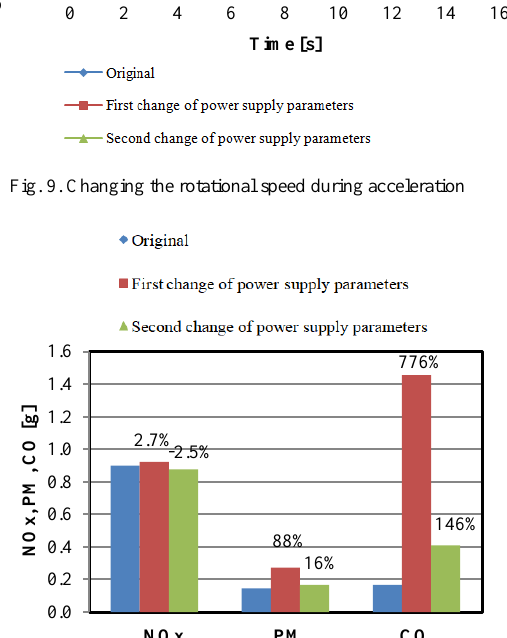
Fig. 10. Emissions of toxic compounds during